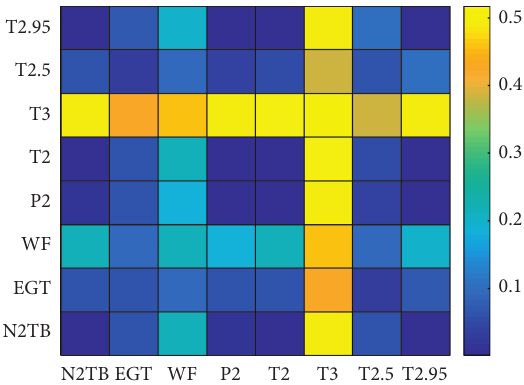
Figure 11: The time delay influence degree for delay τ and N 2 and delay τ